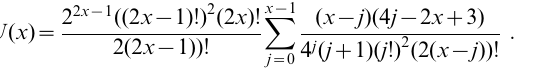
Figure 7. Plot of the computing times (in log scale) needed to compute P ( I , S ) for different values of I ~ S as listed in Table 1. Error bars range between minimum and maximum, while lines connect mean values; all values refer to 10 replicates. Solid line represents computing times obtained by using the recursive formula Eq. 1, while dotted line corresponds to the values produced by using the closed formula Eq. 2.